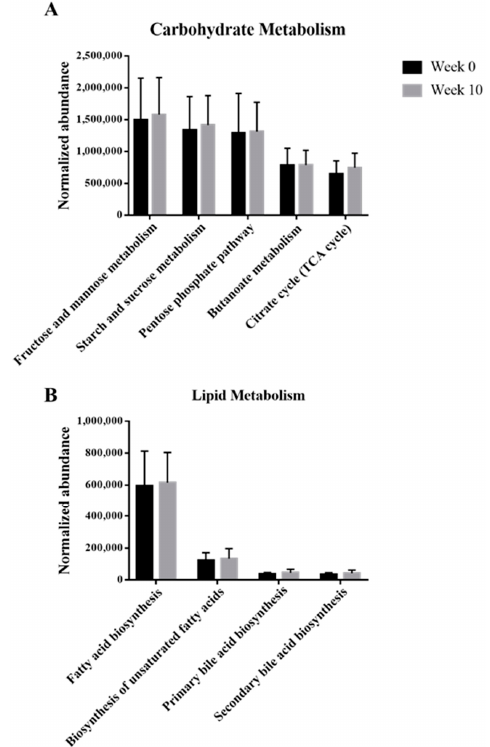
Figure 4. Functional annotation of the gut microbiomes between week 0 and 10 with the administra- tion of the synbiotic preparation containing L. gasseri BNR17. Normalized abundance of the level 2 KEGG subsystem classified reads associated with the metabolism of carbohydrate ( A ), and lipid ( B ). The error bars show the calculated standard error of the means of five replicates of the samples.